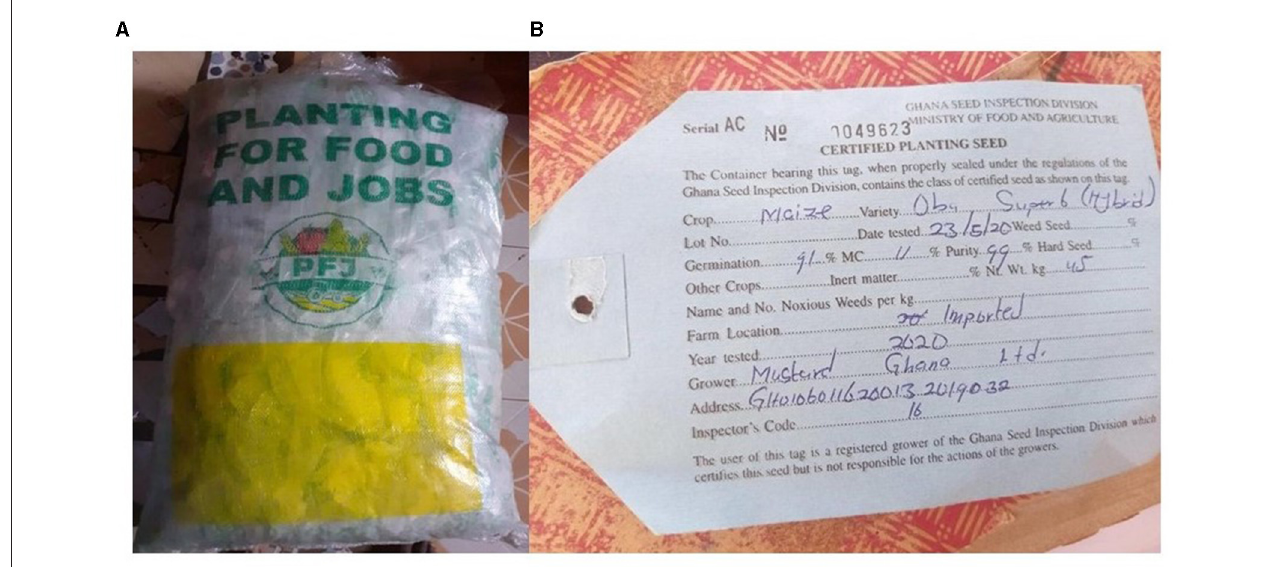
FIGURE 3 | (A) The government branded PFJ sacks containing maize seeds. (B) Ghana Seed Inspection Division label for imported hybrid.